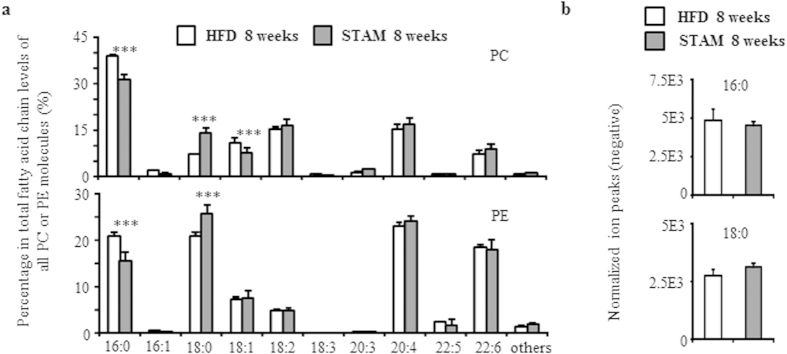
Fatty acid levels between 8-week old HFD and STAM mice.a, Abundance of each fatty acid as percentage of all side chains, calculated as the ratio of the sum of ion peak heights containing the fatty acid to 2× the sum of peak heights of all PC or PE (one PC or PE contains two fatty acid chains). Data are mean ± SD (n = 5 in each group). ***p < 0.005 when comparing control HFD vs. STAM mice. 16:0, palmitate; 16:1, palmitoleate; 18:0, stearate; 18:1, oleate; 18:2 linoleate; 18:3, linolenate; 20:3, eicosatrienoate; 20:4, arachidonate; 22:5, docosapentaenoate; 22:6, docosahexaenoate. b, Levels of free palmitate (16:0) and stearate (18:0) expressed as mean ± SD (n = 5 in each group).